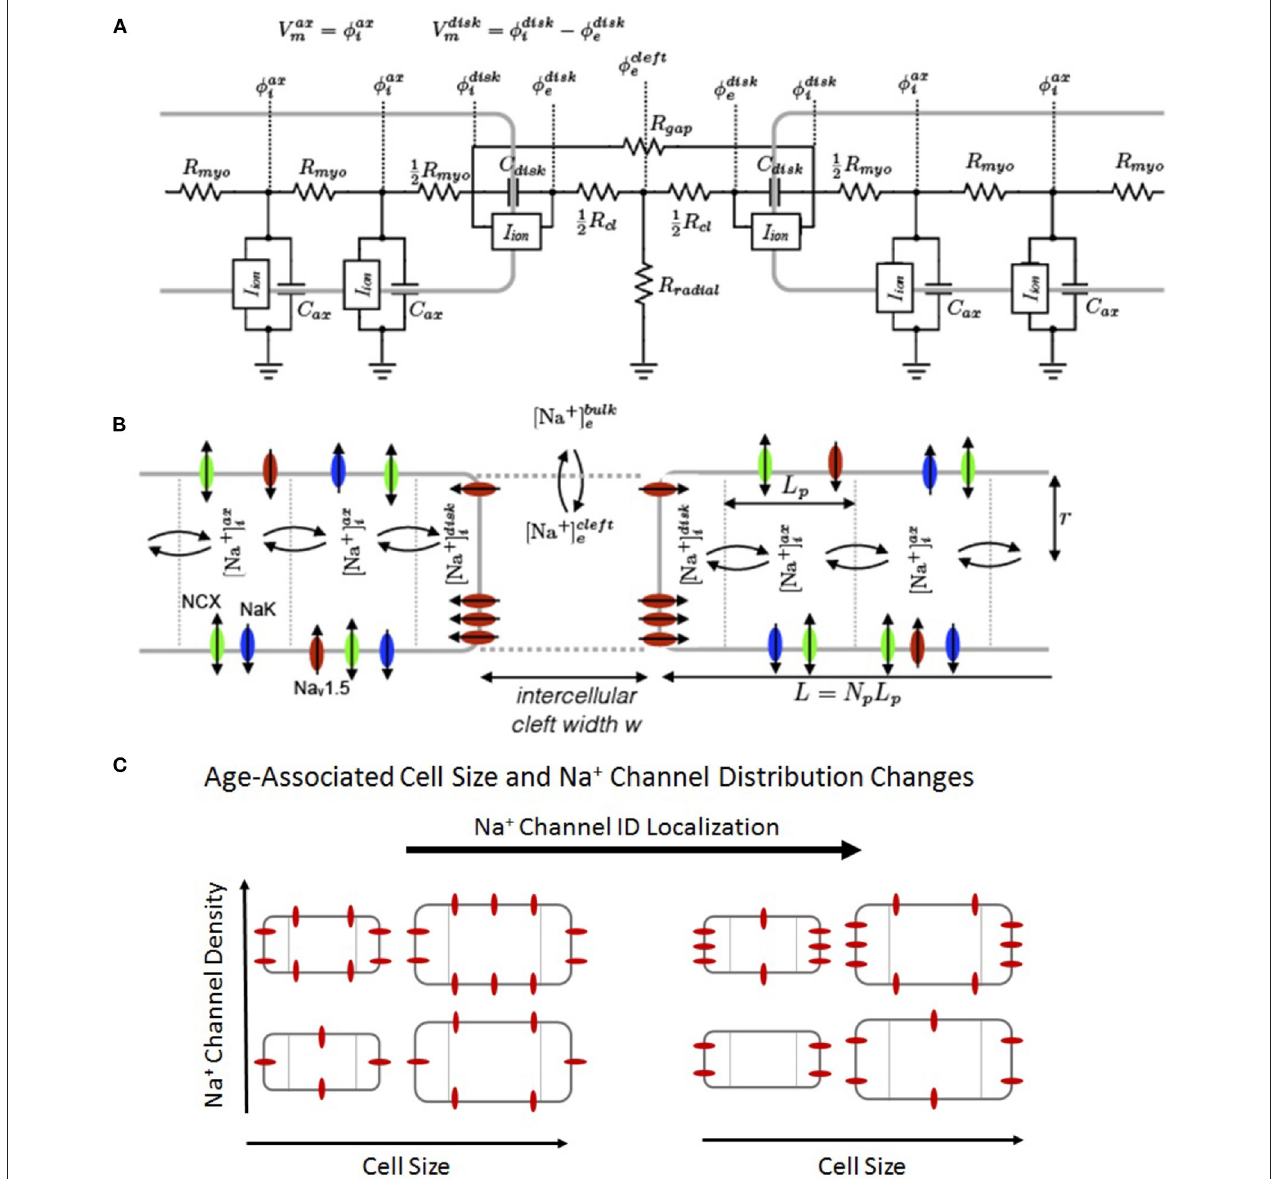
FIGURE 1 | Schematic of the computational model. (A) Electric circuit representation of coupled myocytes. Intracellular nodes are coupled via a myoplasmic resistance ( R myo ). End nodes are coupled via a gap junctional resistance ( R gap ). Extracellular potentials at the disc and intercellular cleft ( φ disc e and φ cleft e , respectively) are governed by a T-shaped network of two axial resistances in the intercellular cleft ( R cl ) and one radial resistance ( R radial ). (B) Na + concentration in diffusively coupled compartments, including intracellular Na + in the axial and disc compartments ([ Na + ] ax i and [ Na + ] disc i ) and extracellular Na + in the intercellular cleft and bulk spaces ([ Na + ] cleft e and [ Na + ] bulk e ). (C) Representation of age-associated change in model parameters, including changes in cell size ( S ), Na + channel density ( ρ Na ), and Na + channel ID localization ( ID Na ).